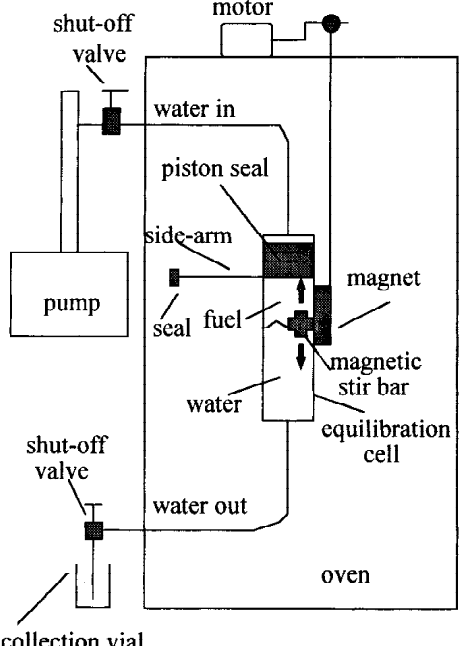
Figure 2. Experimental system of determination solubility and partitioning behavior of fuel components in subcritical water designed by Yang et al. (Adopted from Reference [9] with permission from the American Chemical Society; Copyright 1997).